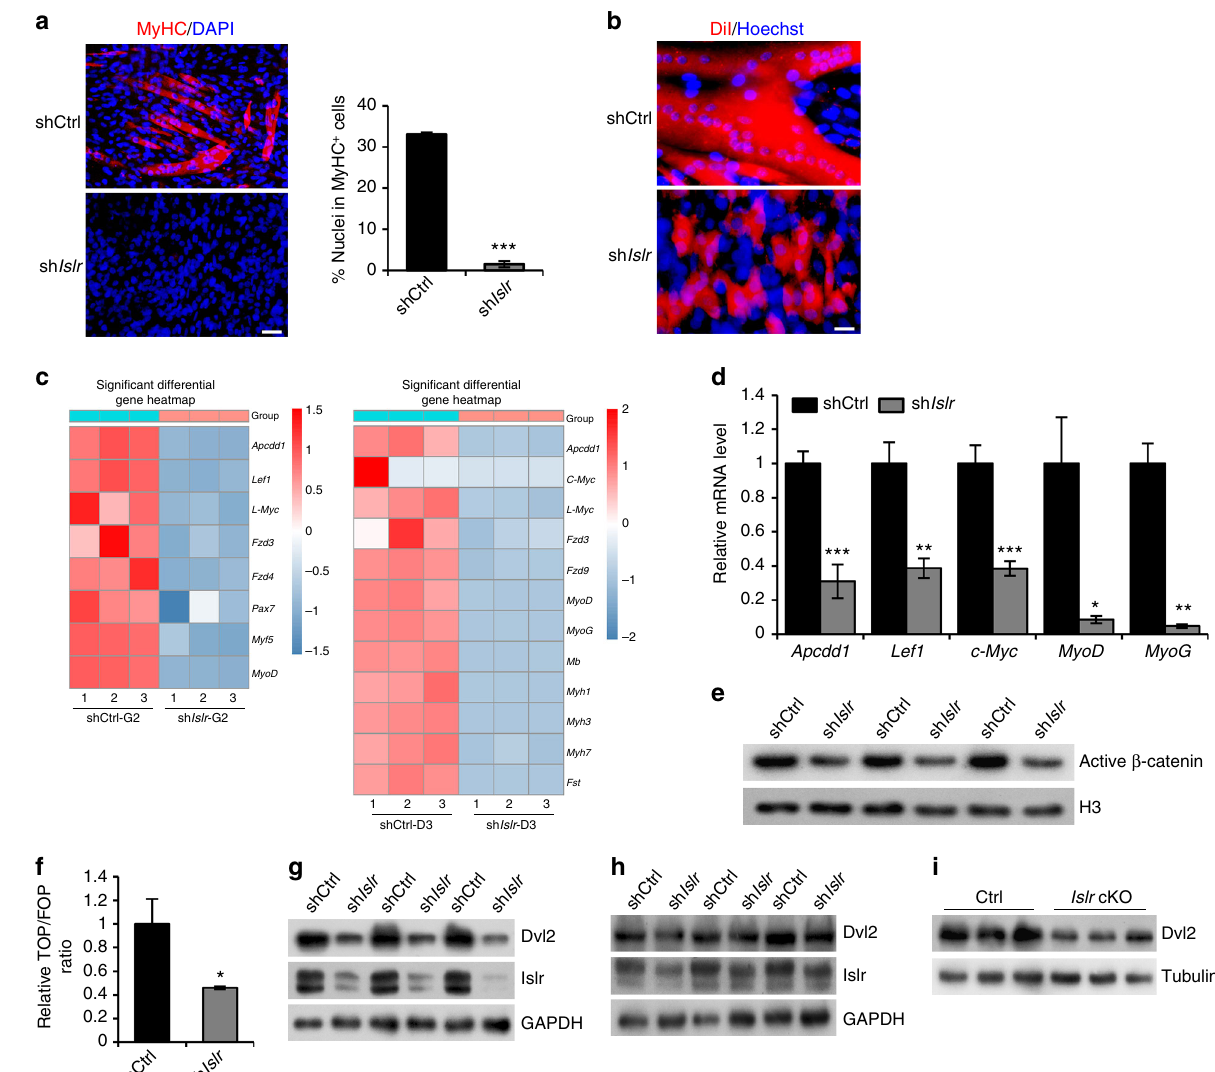
Fig. 6 The disruption of Islr downregulates the Dvl2-mediated canonical Wnt signaling pathway in myoblasts. a Immuno fl uorescence staining for MyHC in control shRNA (shCtrl) and Islr shRNA stable (sh Islr ) C2C12 cells. N = 3 cell cultures in each group. Scale bar = 50 μ m. The percentage of MyHC + cells is shown on the right. b Immuno fl uorescence analysis of cell morphologies in shCtrl and sh Islr C2C12 cells by staining live cells with DiI. N = 3 cell cultures in each group. Scale bar = 25 μ m. c Heatmap of the changes in selected gene expression levels in shCtrl and sh Islr C2C12 cells at G2 and D3 by RNA-seq. d Expression analysis of Wnt target genes and myogenic genes in shCtrl and sh Islr C2C12 cells at 3 d in differentiation medium using qRT-PCR. e Western blot analysis of active β -catenin protein levels in nuclear lysates extracted from shCtrl and sh Islr C2C12 cells after 7 d in differentiation medium. f Luciferase activity of TOP/FOP in shCtrl and sh Islr C2C12 cells after 3 d in differentiation medium. g Western blot analysis of Islr and Dvl2 protein levels in shCtrl and sh Islr C2C12 cells after 2 d in growth medium. h Western blot analysis of Islr and Dvl2 protein levels in shCtrl and sh Islr C2C12 cells after 7 d in differentiation medium. i Western blot analysis of Dvl2 protein levels in primary myoblasts of control and Islr cKO mice after 3 d in differentiation medium. Error bars represent the means ± s.d. * P < 0.05, ** P < 0.01, *** P < 0.001; Student ’ s t